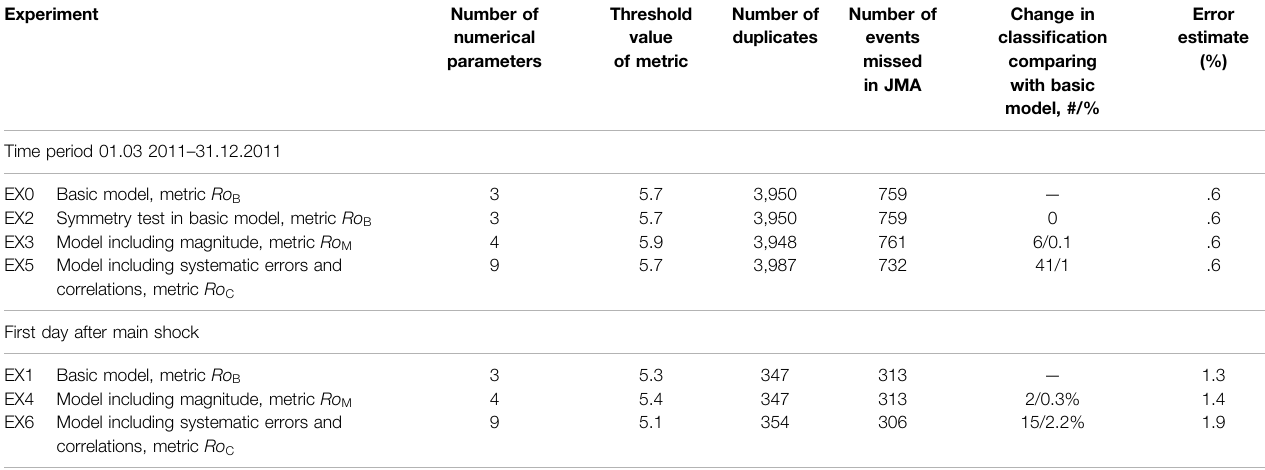
TABLE 1 | Summary of numerical experiments.